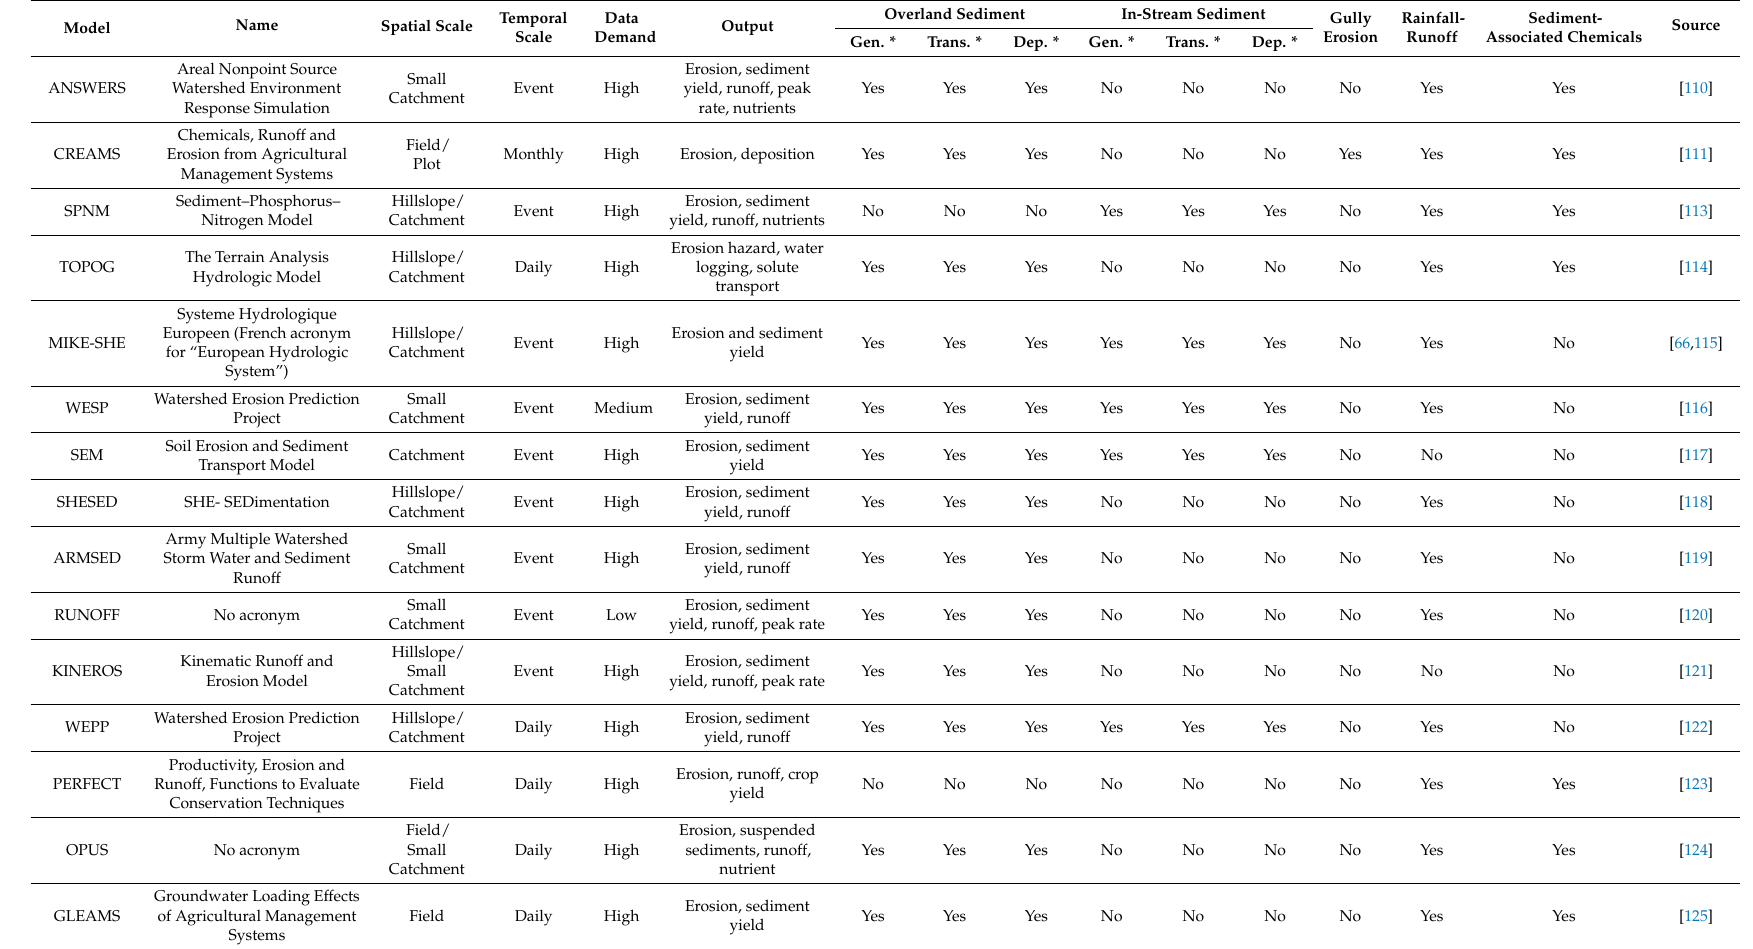
Table 3. Physically-based soil erosion